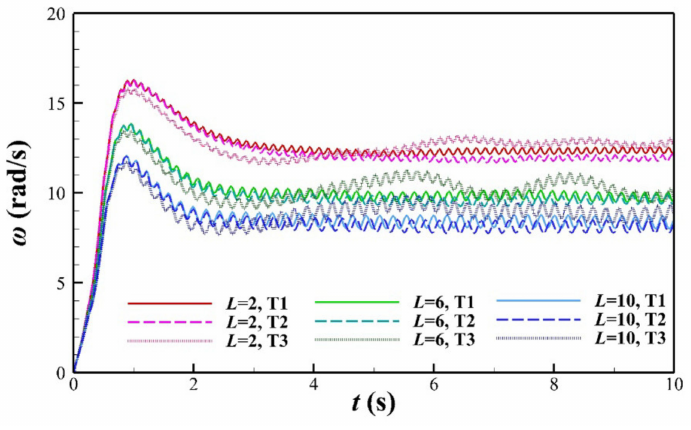
Figure 14. Comparison of time histories of rotation